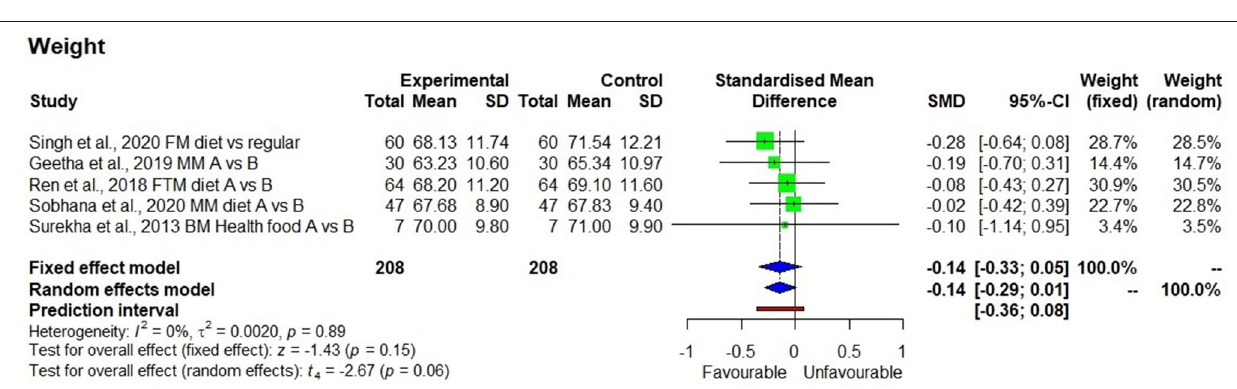
FIGURE 6 | Effect of consuming millets on high-density lipoprotein-cholesterol (HDL-C) level (pre- vs. post-treatment or intervention vs. control diet).